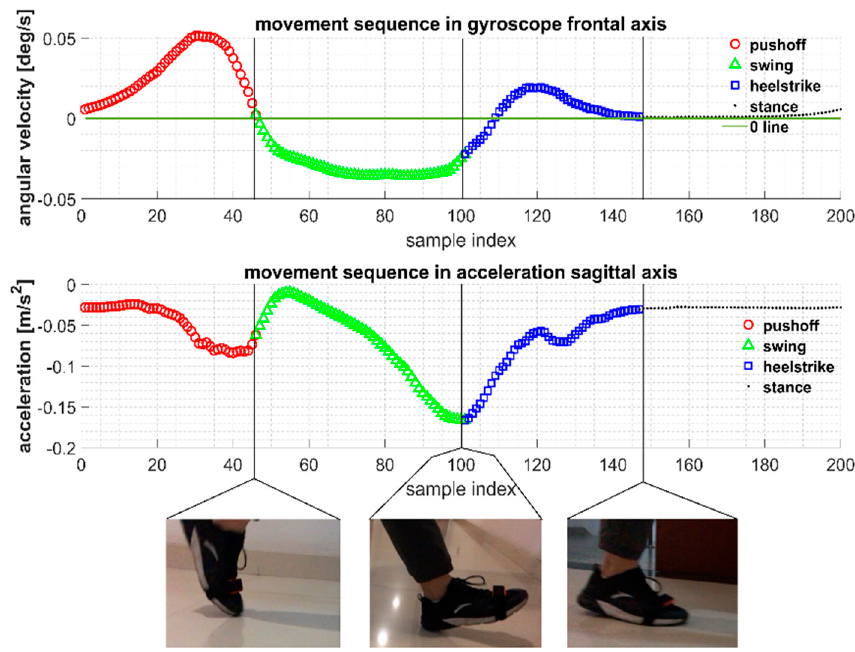
Figure 8. The time range of gait labels in video recordings can be converted to IMU sequence with the assurance of time synchronization, which performs as the basis of gait analysis and gait phase recognition.